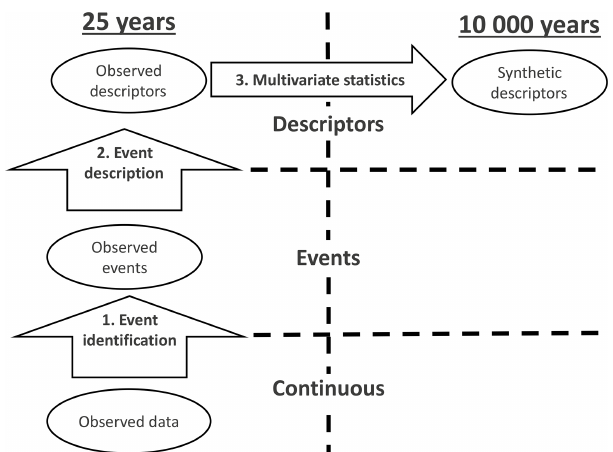
Figure 1. The applied framework, which comprises three steps. First, events are identified in the observed data. Second, the ob- served events are described, providing a matrix of observed descrip- tors. Third, multivariate statistics is applied to generate a large ma- trix of coherent synthetic